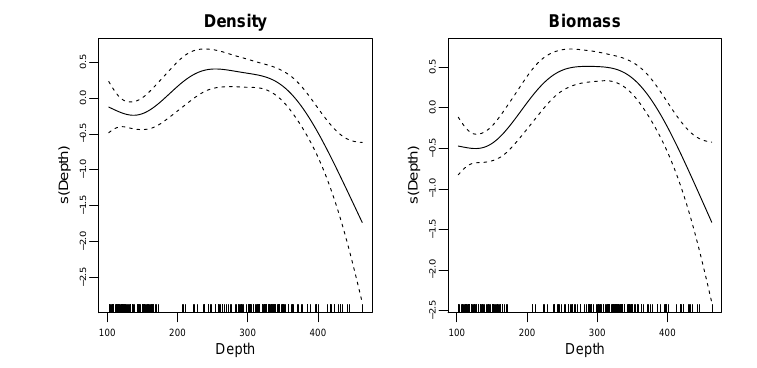
Figure 3 – Fitted depth smooth effects for P. longirostris